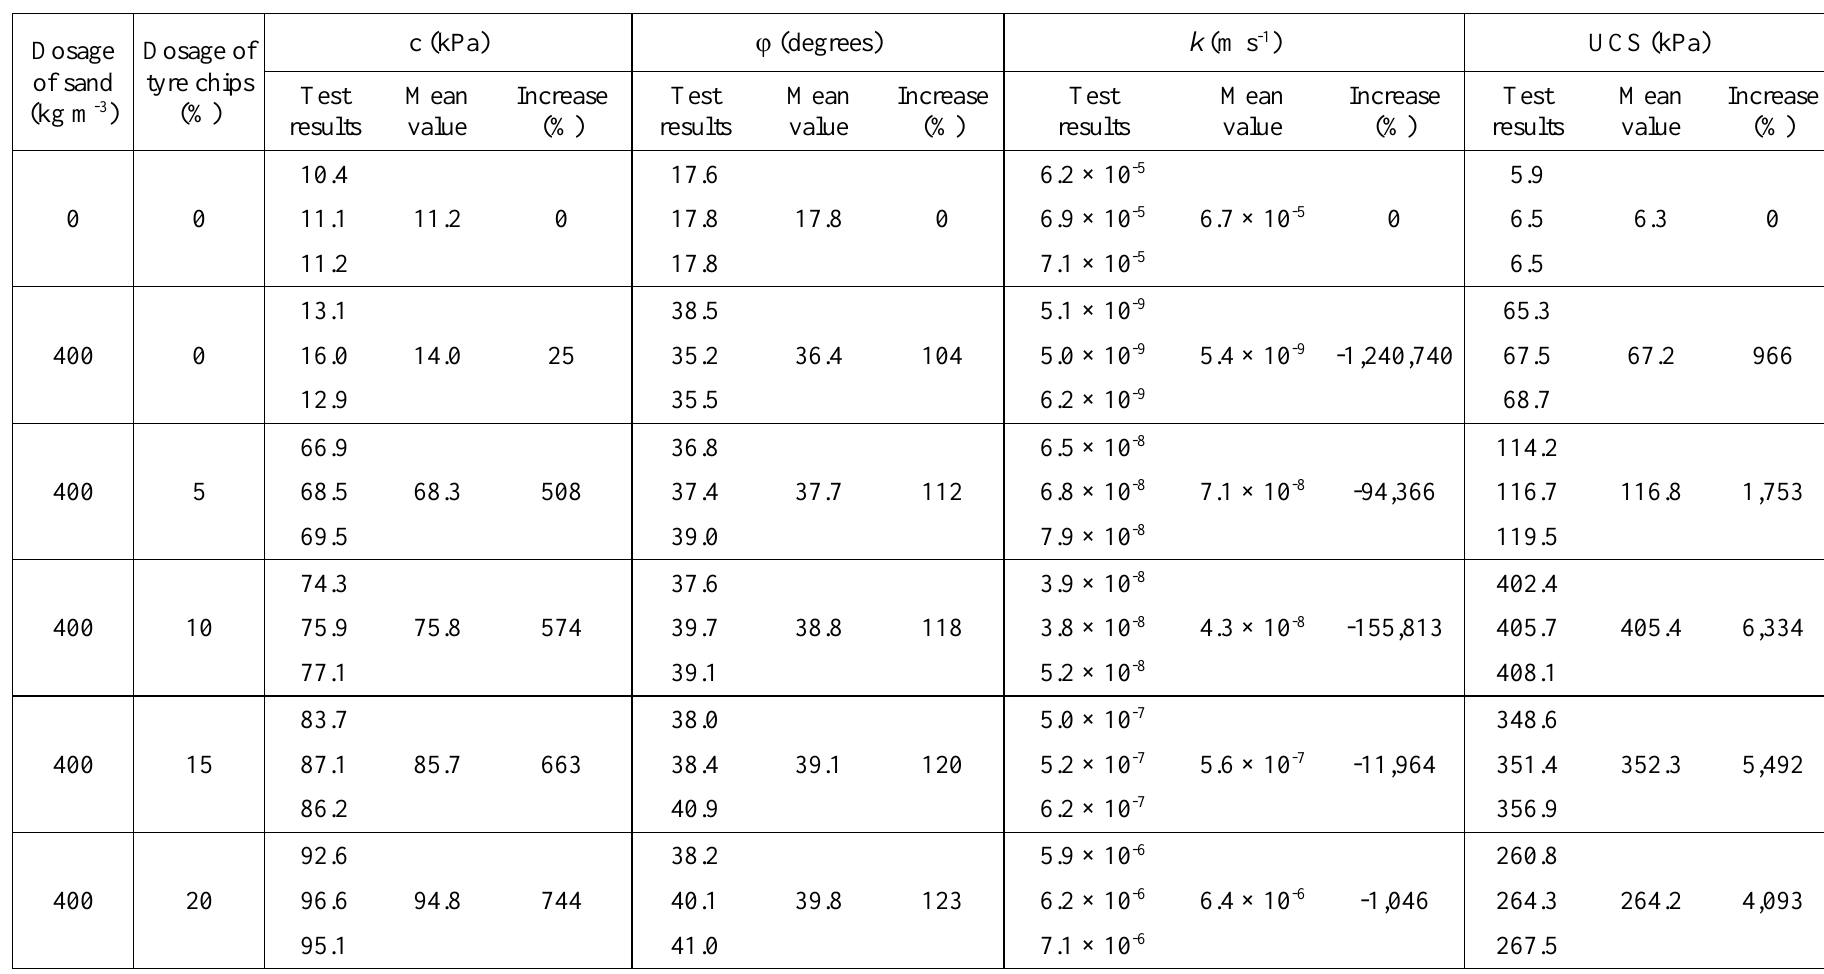
coefficient of permeability k (at 20 °C), and unconfined ,